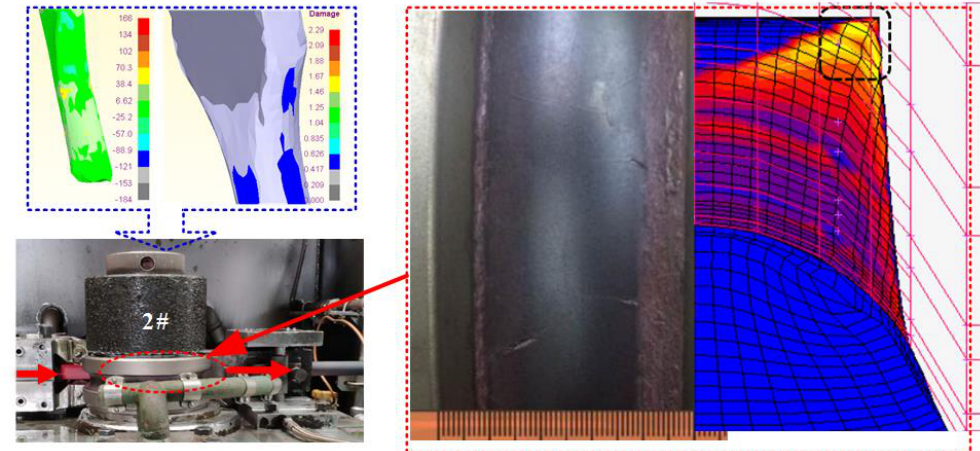
Figure 12. Simulation analysis of rolling interface state.